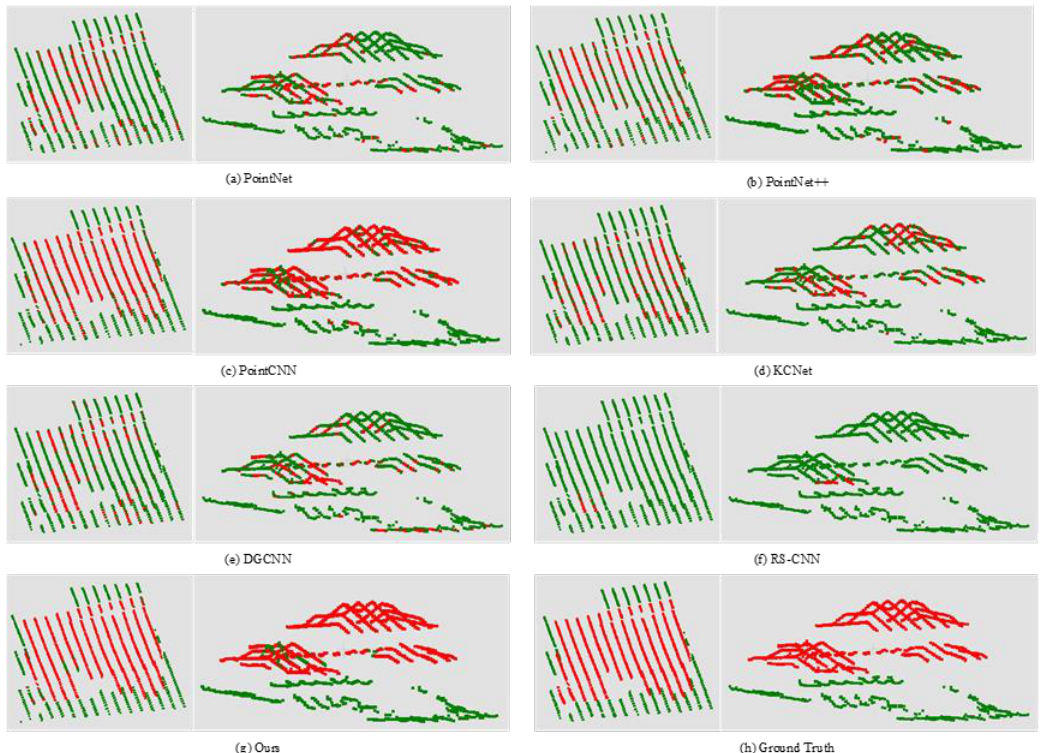
Figure 12. The details visualization of hard level comparison results. For each model, the left image is the vertical view, and the right image is the side view.